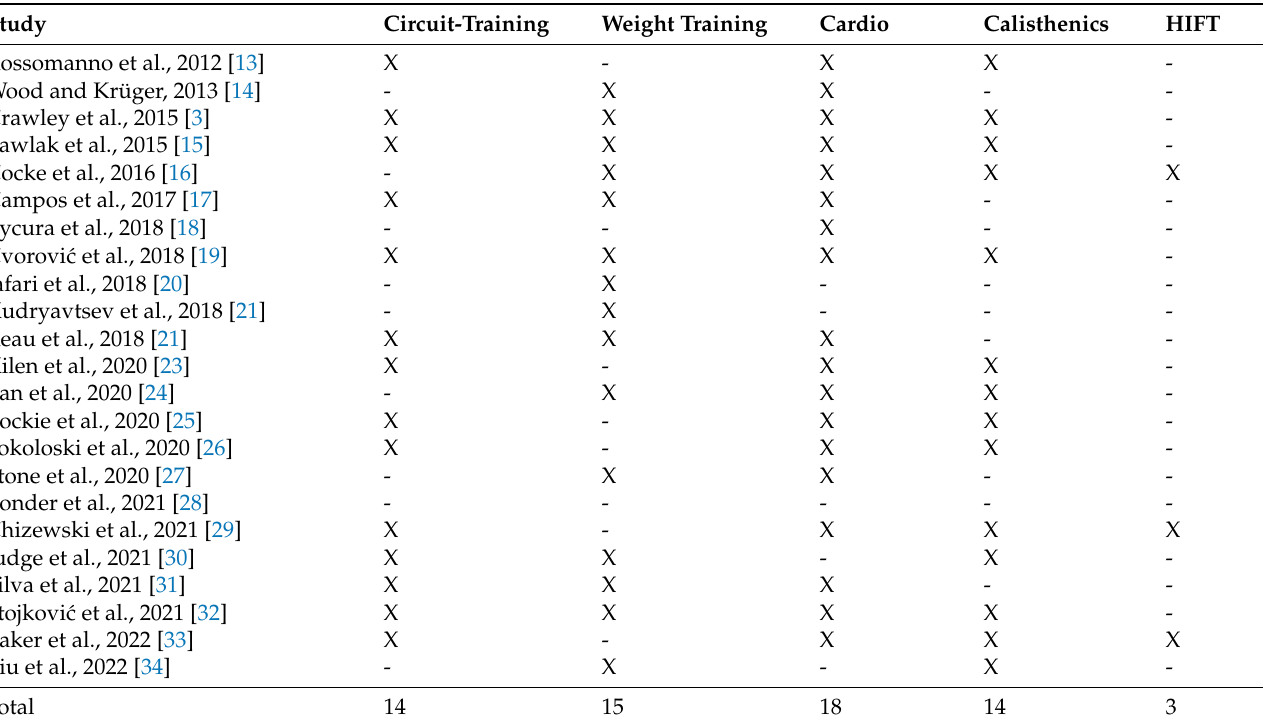
Table 4. Physical training programs